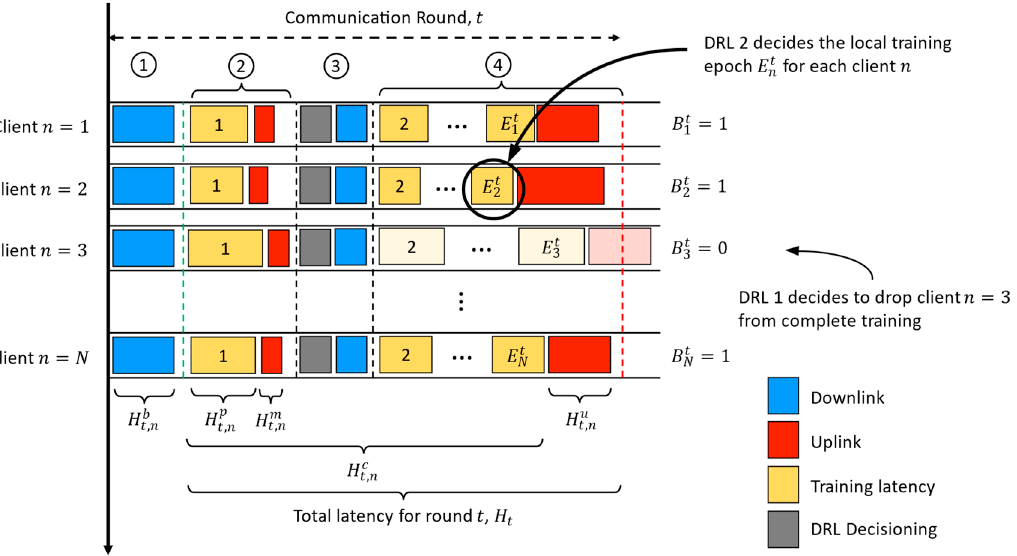
Figure 4. The proposed FL protocol’s system model consists of four phases in each communication round: (1) model broadcasting, (2) probing training, (3) early client termination and (4) completion of training.